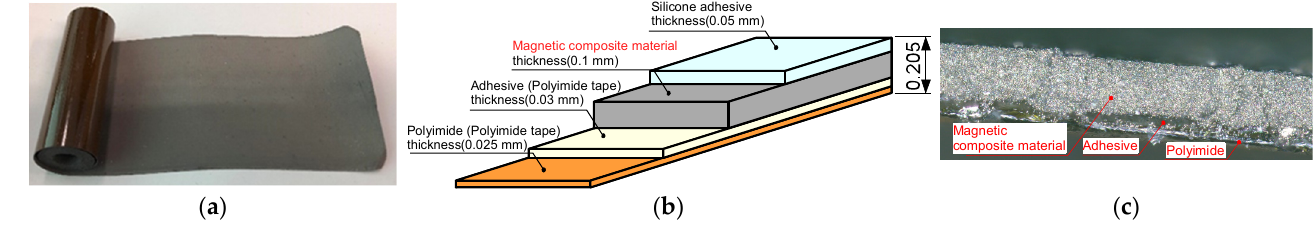
Figure 6. ( a ) Appearance and ( b ) structure of the magnetic tape (all units mm); ( c ) Digital microscope image of the magnetic tape.